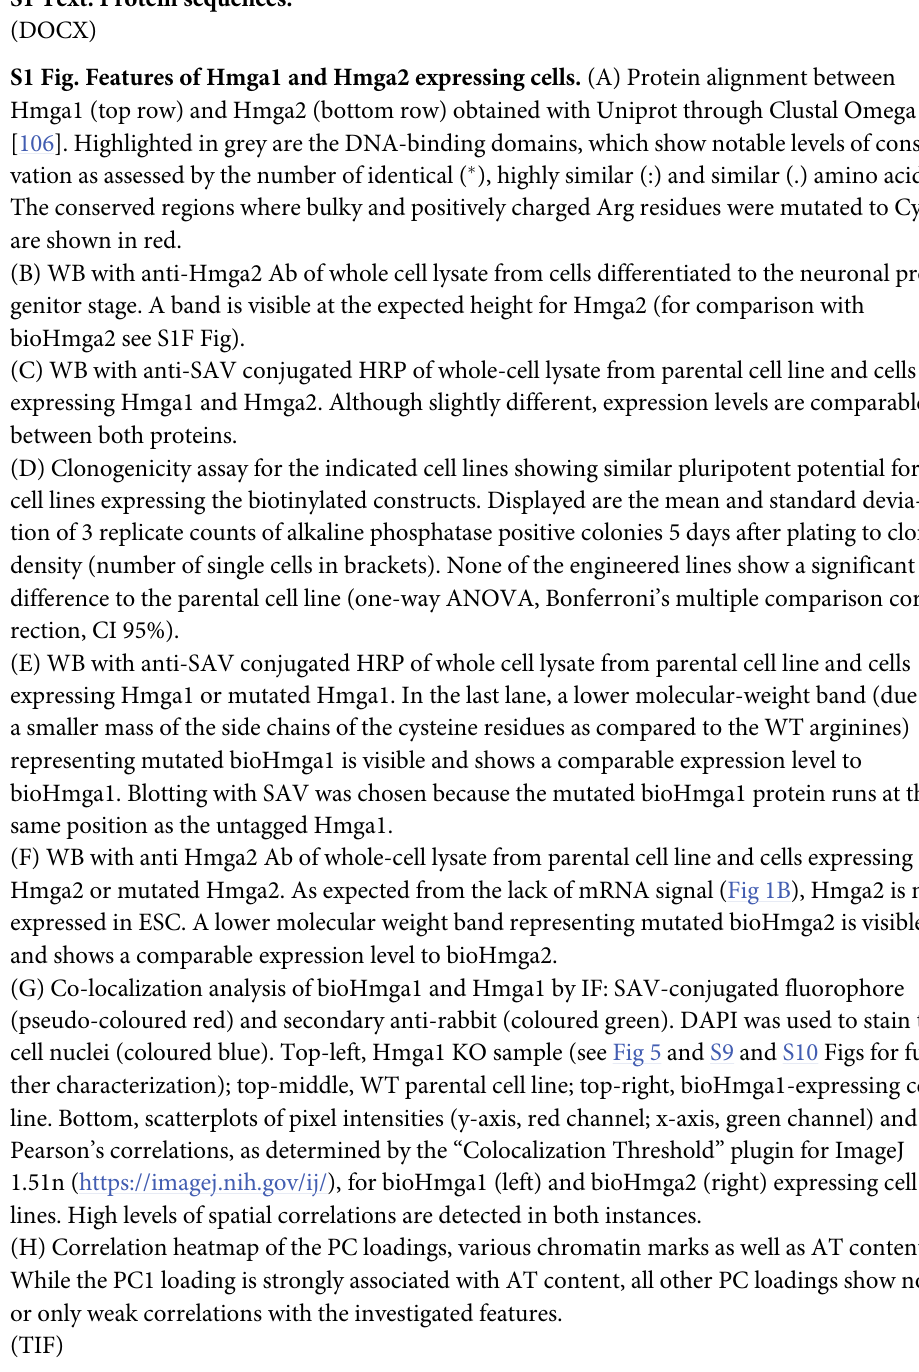
S1 Fig. Features of Hmga1 and Hmga2 expressing cells. (A) Protein alignment between Hmga1 (top row) and Hmga2 (bottom row) obtained with Uniprot through Clustal Omega [106]. Highlighted in grey are the DNA-binding domains, which show notable levels of conser- vation as assessed by the number of identical ( (cid:3) ), highly similar (:) and similar (.) amino acids. are shown in